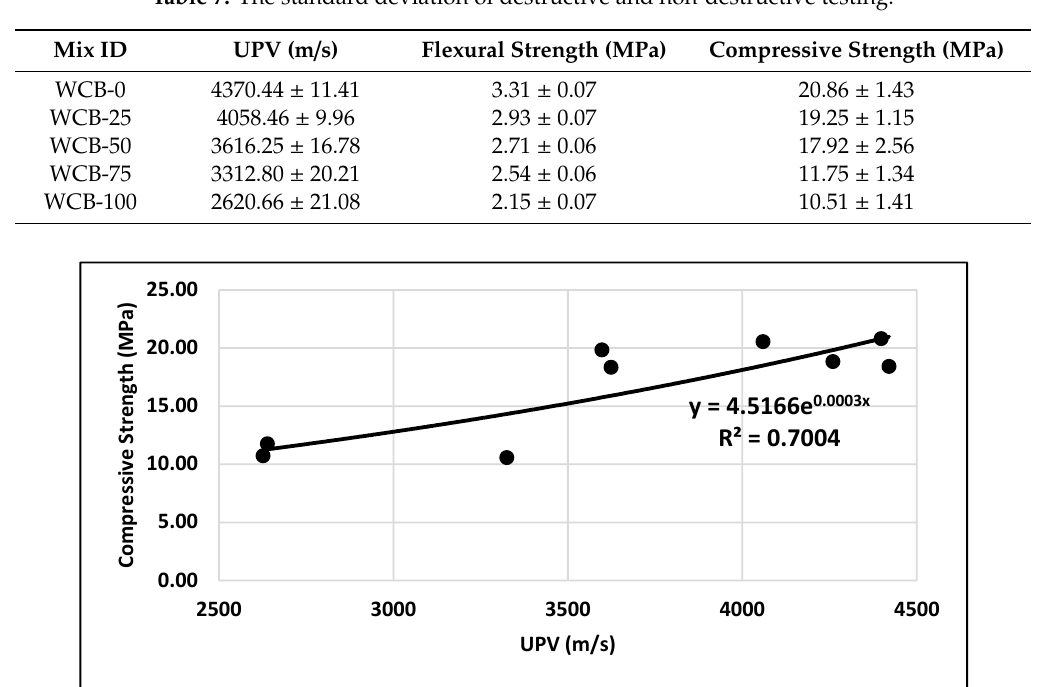
Figure 9. The statistical relationship between compressive strength and ultrasonic pulse velocity.